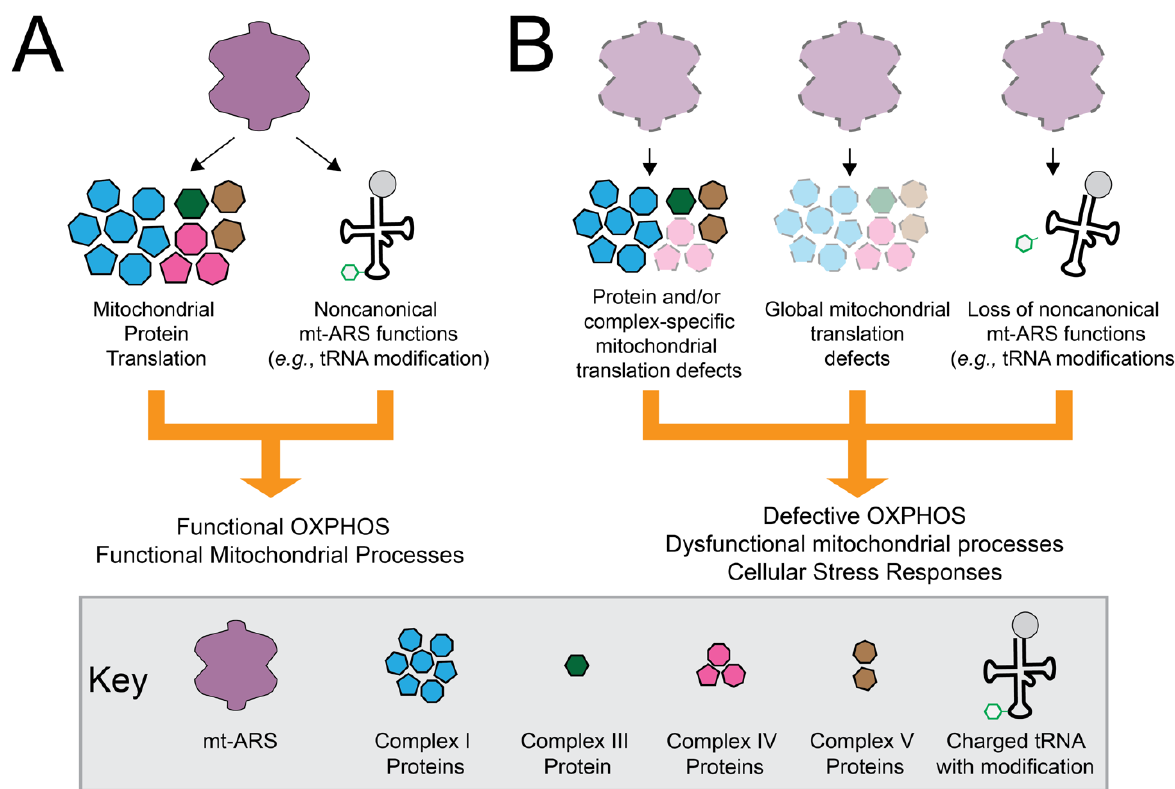
Figure 2. Potential mechanisms by which mt-ARSs may cause inherited disease. ( A ) mt-ARSs charge tRNA in the mitochondria and may also perform secondary functions important for supporting mitochondrial protein synthesis and mitochondrial function (e.g., tRNA modifications). ( B ) Pathogenic mt-ARS variants could disrupt canonical and non-canonical functions, causing protein or complex-specific deficits in mitochondrial translation; global deficits in mitochondrial translation; and/or impaired non-canonical functions, which reduce overall mitochondrial function and potentially activate cellular stress pathways.